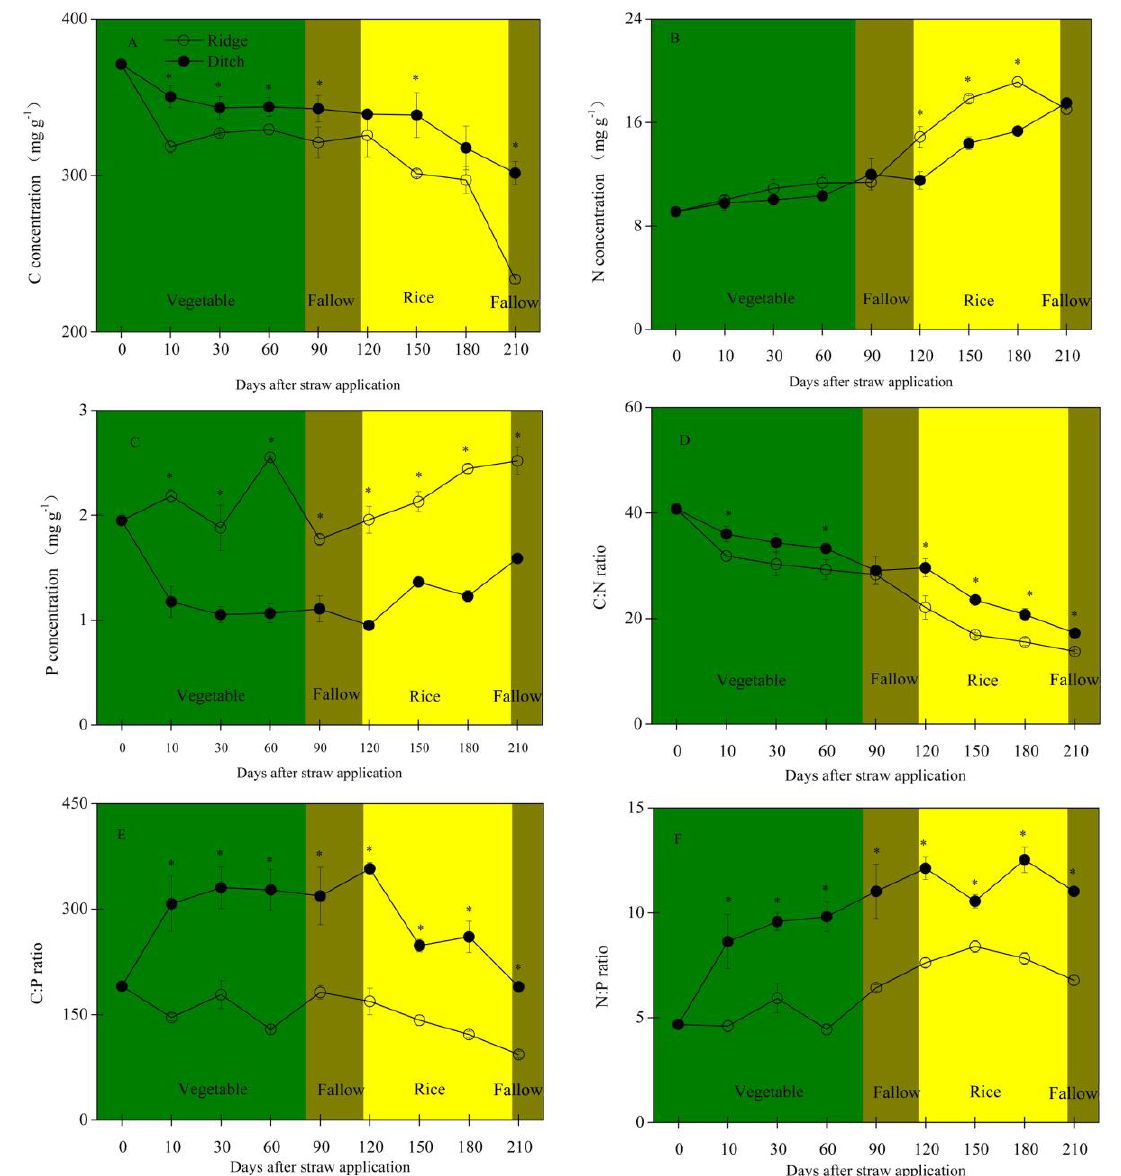
Figure 1. Variation in carbon (C) ( A ); nitrogen (N) ( B ); and phosphorus (P) ( C ) concentrations and C:N ( D ); C:P ( E ); and N:P ratios ( F ) during rice straw decomposition. Statistically significant differences ( p < 0.5) between ridges and ditches in each sampling date are highlighted with (*).